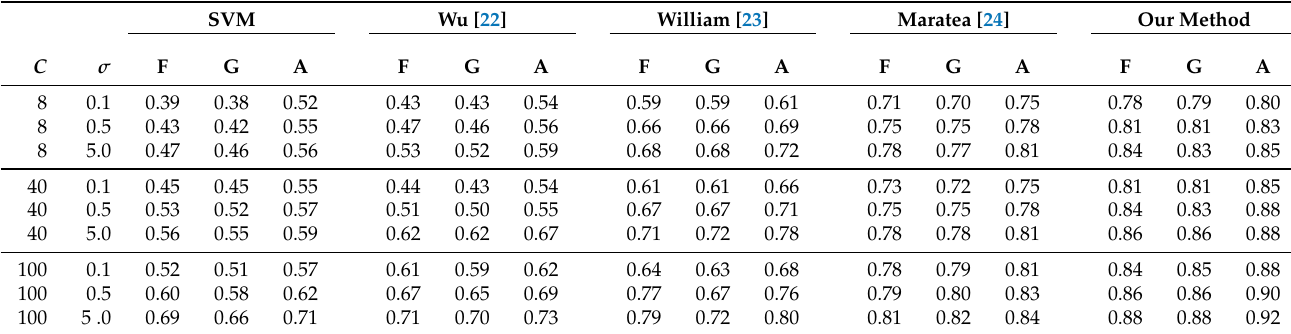
Table 1. F -score (F), G -mean (G) and the AUC (A) measures for all five classification methods in Scenario 1 for n 1 = 200, n 3 = 200 and n 3 = 200, respectively. Max margin is 0.02.